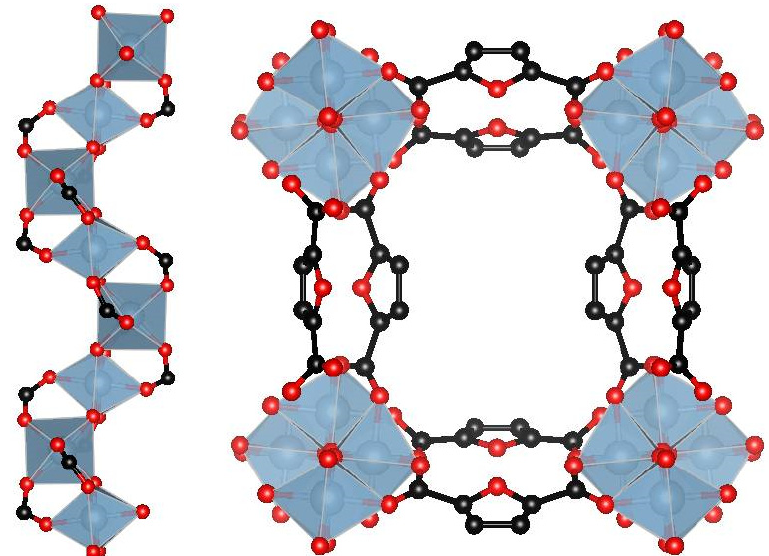
Figure 1. Scheme of the MIL-160 structure: helical inorganic chains formed by AlO6 octahedra ( left ); channels in framework constructed from inorganic chains linked via carboxylate groups of the 2,5-furandicarboxylic acid ( right ). AlO 6 octahedra (light gray), atoms C (black), O (red).